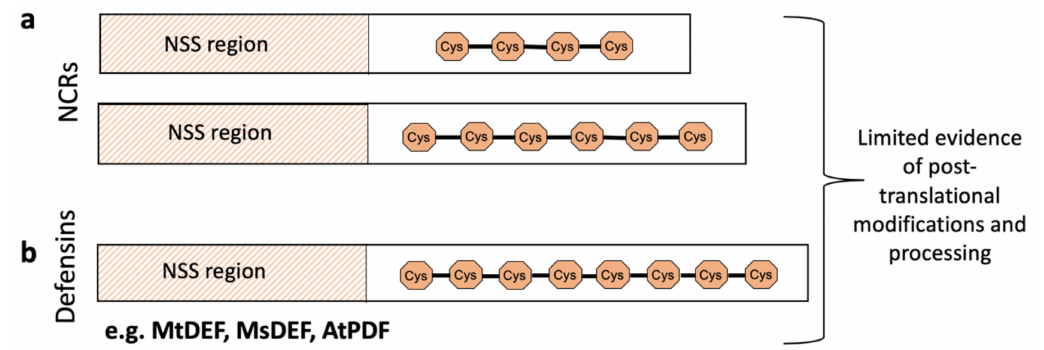
Figure 2. Simplified precursor structure of NCR peptides with defensins for comparison. ( a ) NCRs in indeterminate legumes such as Medicago truncatula and Aeschynomene are characterised by the presence of a signalling peptide at the 5’ end and four or six cysteines at conserved positions. ( b ) Defensins similarly have a 5’ signal peptide but have eight cysteine residues. Post-translational modifications, such as phosphorylation and lysine acetylation, have only been observed for eight NCR peptides: Medtr6g043380.1, Medtr7g051320.1, Medtr6g463200.1, Medtr7g029760.1, Medtr3g065710.1, Medtr2g044330.1, Medtr4g033290.1 and AES72906